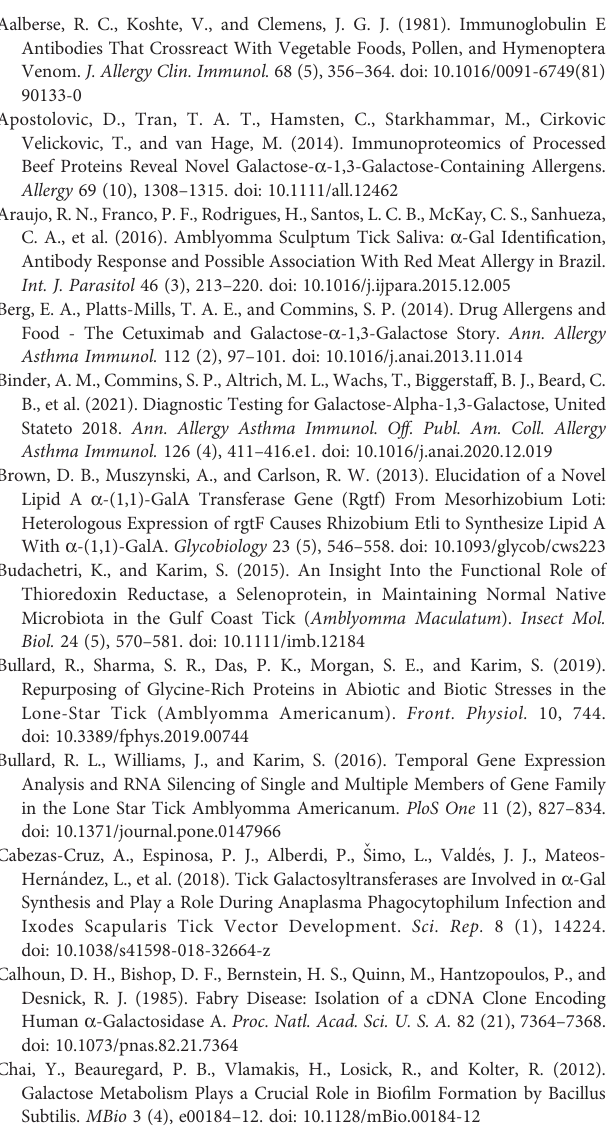
Supplementary Figure 1 | Proposed galactose metabolism pathway of Amblyomma americanum. Supplementary Figure 2 | Quanti fi cation of relative abundance of a -gal in dsADGal ( a -galactosidase) and dsGFP (irrelevant control)-injected partially-fed Am. americanum salivary glands. Supplementary Figure 3 | FTMS of N-glycans observed in control salivary gland Supplementary Figure 4 | FTMS of N-glycans observed in KO salivary gland Supplementary Figure 5 | (A) Transcriptional expression of major galactose metabolism, N-glycan synthesis- and transport-related genes against ß-1,4 galactosyl transferase silencing in 5-day partially feed salivary gland (SG) of Am. americanum . Actin and histone were used as housekeeping genes, and expression was normalized against irrelevant control (GFP dsRNA). Abbreviation: ADgal, a -D- galactosidase; ß-1,4 GT, ß-1,4 galactosyl transferase; GALK, Galacto kinase;